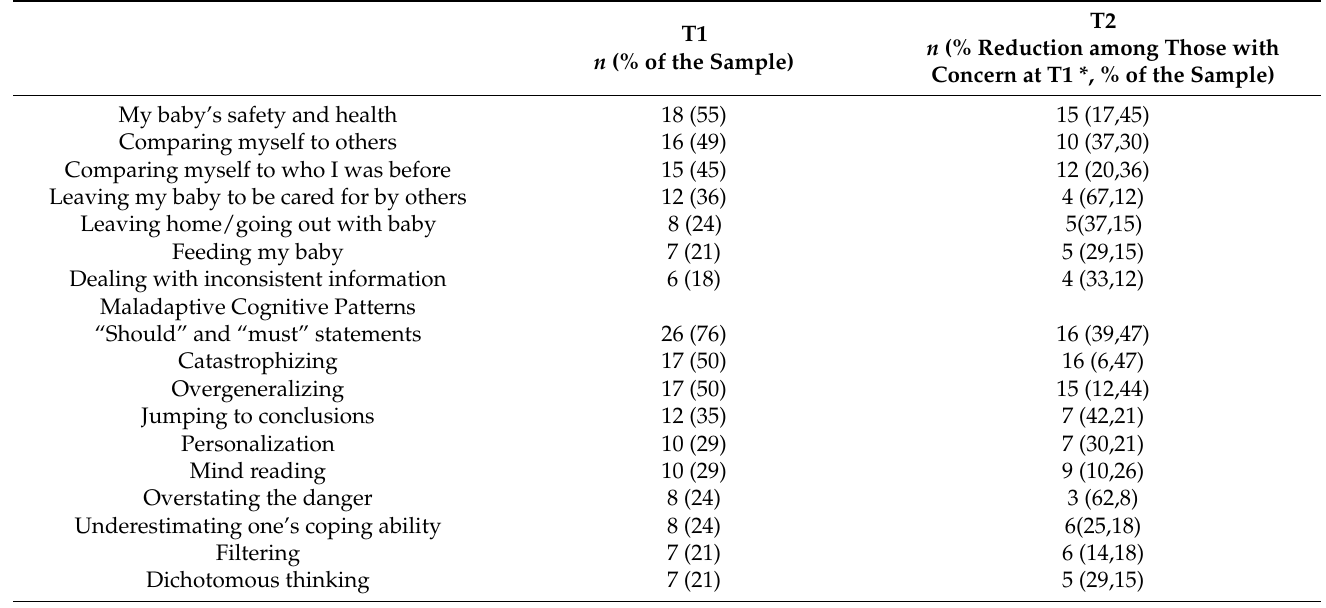
Table 5. Percentages of responses on issues that aroused anxiety before (T1) and after the intervention (T2), n = 34.